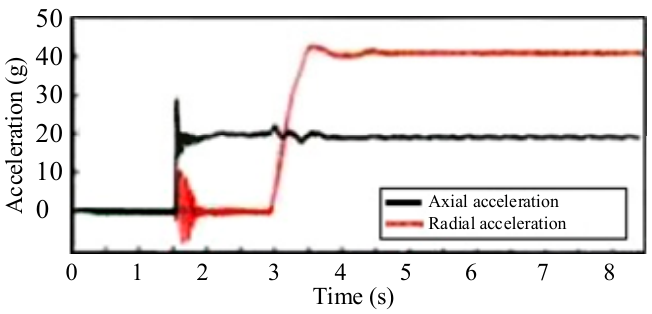
Figure 17. 2-D dynamic acceleration test results of the unit with the synchronous loading .